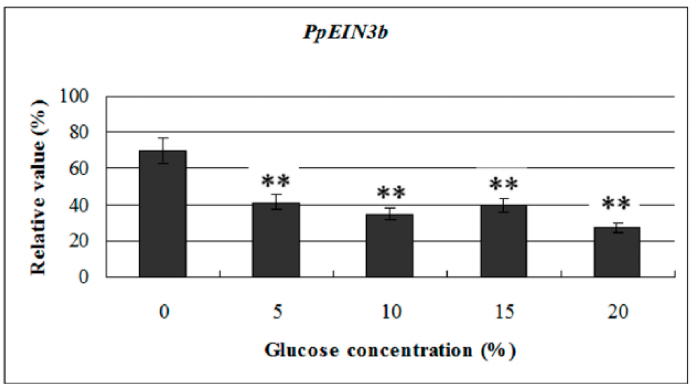
Figure 6. qRT-PCR analysis of expression of PpEIN3b in fruit under glucose treatment for 12 h. Relative values of expression of PpEIN3b in fruit 10 days after harvest treated with 0, 5%, 10%, 15%, and 20% glucose for 12 h shown as percentage of PpUBI expression. Mean values and standard errors (bar) are shown from three independent experiments. Independent t tests for equality of means show very significant di ff erence (** p value < 0.01) between control and treated fruit.